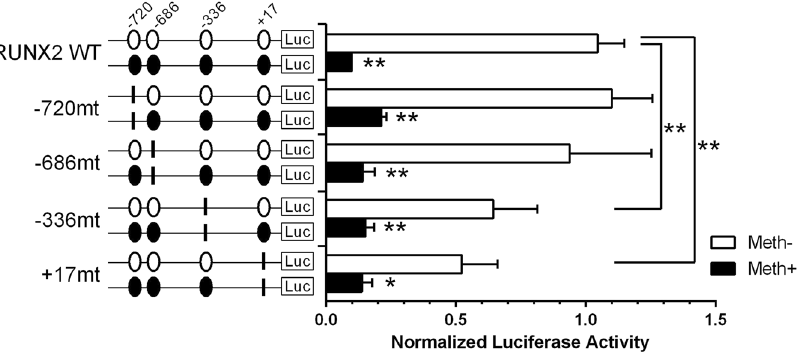
Figure 6. CpG methylation, and specific mutations at the − 336-bp and + 17-bp CpG sites decrease RUNX2 promoter activity. Assessment of activities of methylated or non-methylated RUNX2 promoter constructs containing different mutations was performed by luciferase assay. Point mutations (CG to TG) were created at CpG sites located at − 720-bp, − 686-bp, − 336-bp, and + 17-bp. Values are the mean ± SD of 4 independent experiments. * P < 0.05, ** P <